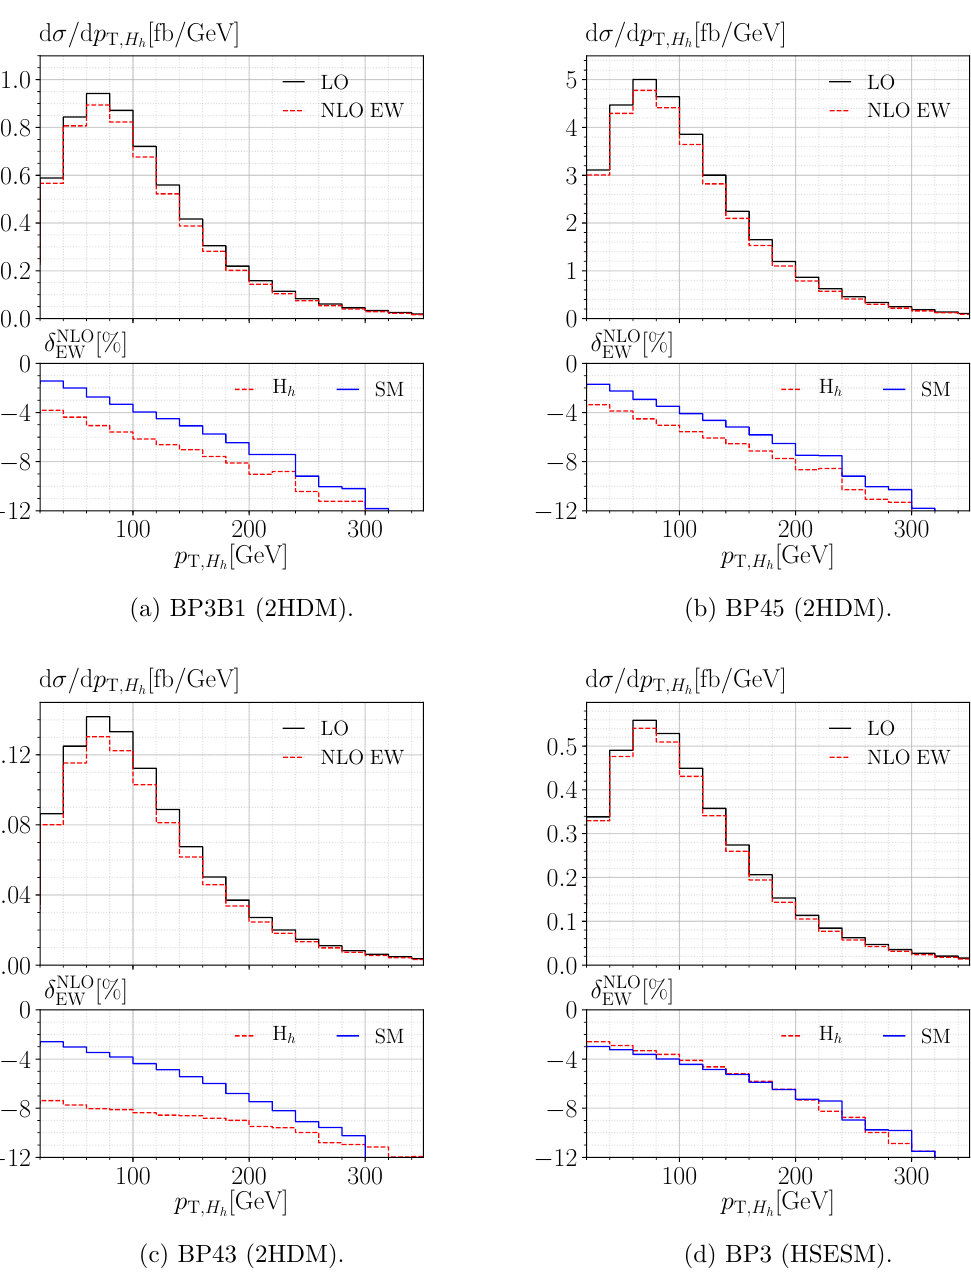
Figure 4. Distributions in the transverse momentum of the Higgs boson p production in VBF for the benchmark points BP3B1 in (a), BP45 in (b) and BP43 in (c) in the 2HDM, and BP3 in (d) in the